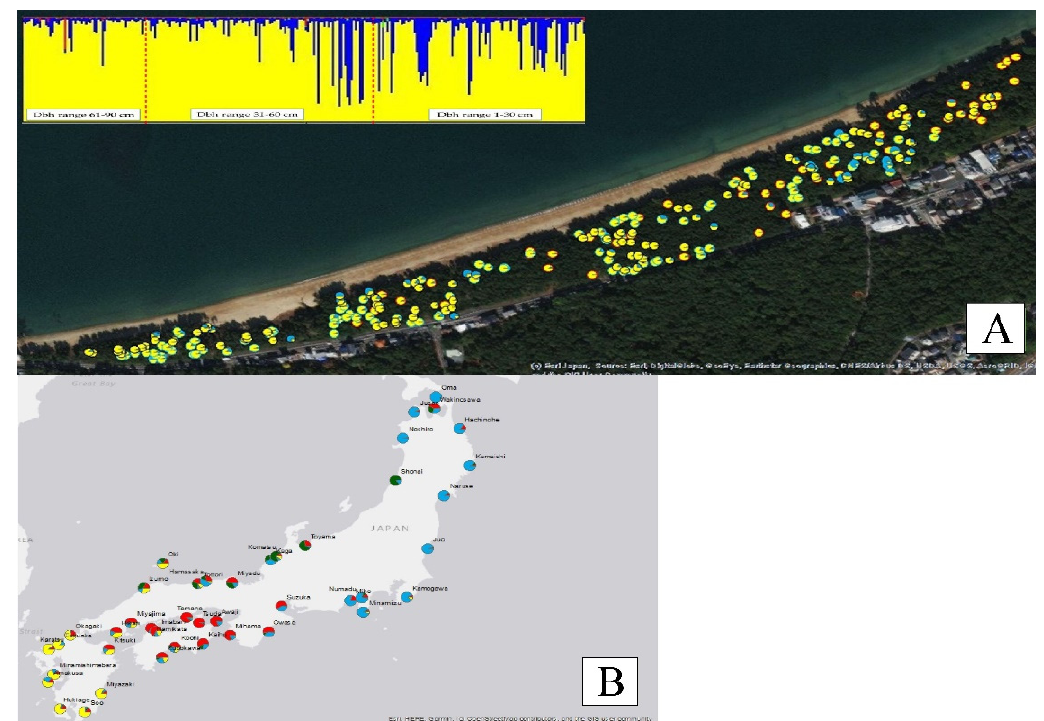
Figure 1. Spatial distribution of genetic structure at Iki-no-Matsubara ( A ); Iki-no-Matsubara with 42 old populations of P. thunbergii throughout Japan ( B ).